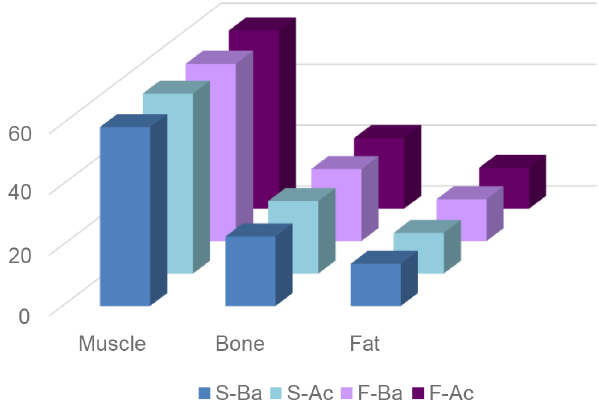
Figure 2. Carcass tissular proportion of lambs fed acorn-based